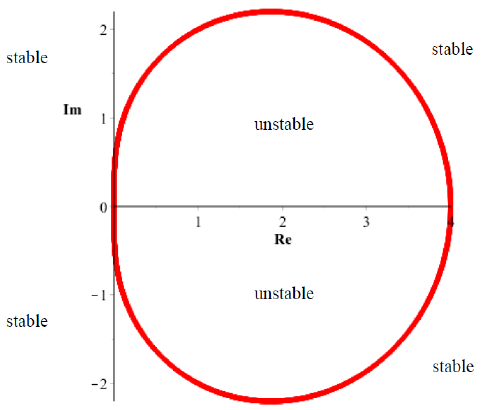
Figure 3. Stability graph of 2-point SDIBBDF method.